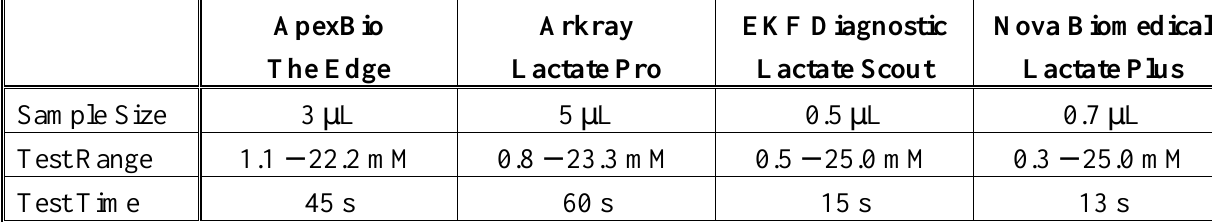
Table 2. Comparisons between four commercial lactate